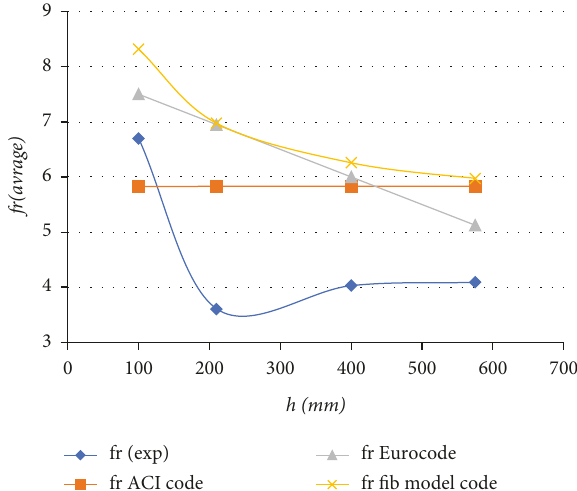
Figure 13: Effect of beam depth on modulus of rupture ( f